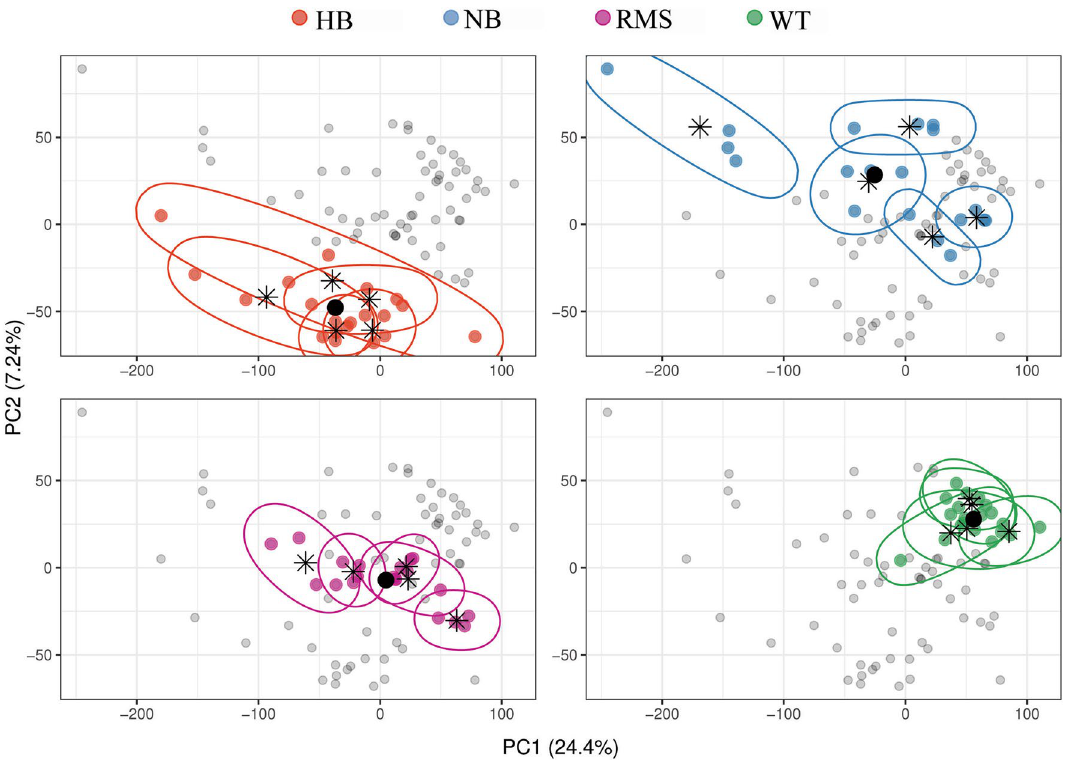
Figure 2. Principal Component Analysis. The plot shows a Principal Component Analysis (PCA) made on the gene expression profiles of 79 samples (dots). The x- and y-axis represent the first two principal components, PC1 and PC2 respectively, which together explain about 31.6% of the total variance. In each panel samples for each histotype are highlighted by different colors (HB: red dots; NB: blue dots; RMS: purple dots; WT: green dots). Samples coming from the same case are encircled and stars represent their center, whereas big black dots represent the center of the histotype. Grey dots represent samples of the other